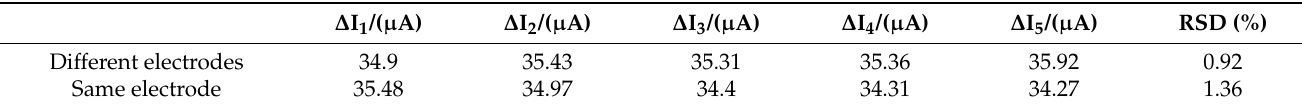
Table 2. The reproducibility of MIP/TBC/GCE sensor.